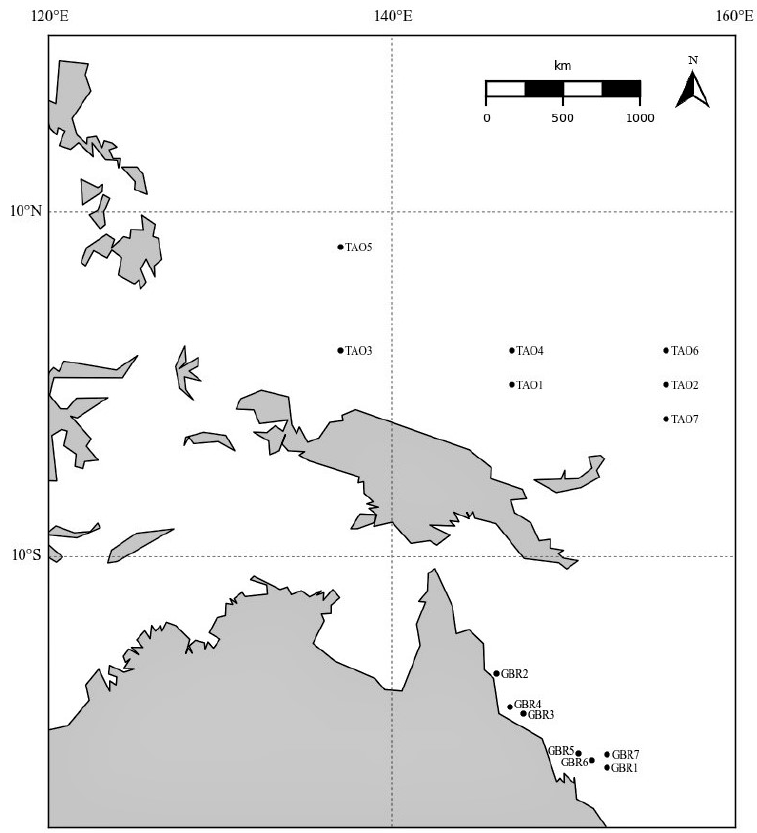
Figure 1. Locations of in situ stations providing subsurface temperatures for this study.